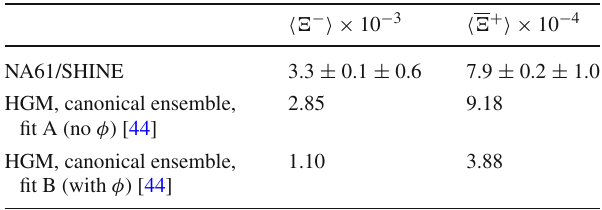
Table 7 The mean multiplicity of (cid:2) − and (cid:2) + hyperons produced in inelastic p+p interactions at 158 GeV / c compared to theoretical multi- plicities obtained within Hadron Gas Models